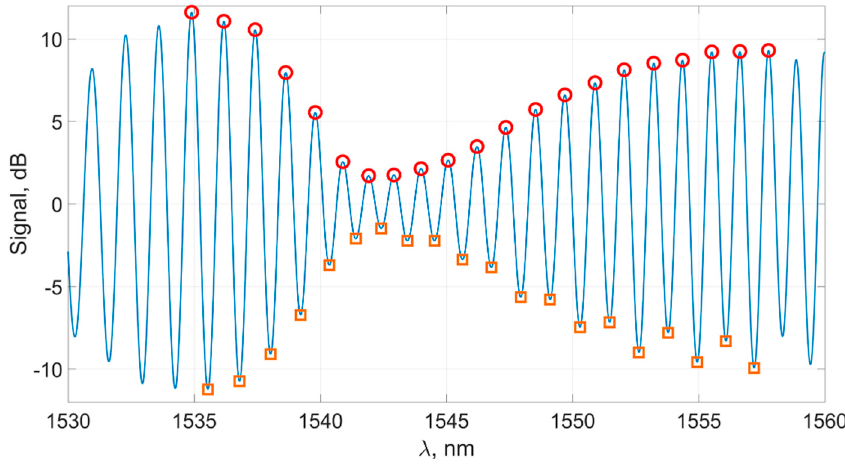
(cid:95) Ext top (circles) and